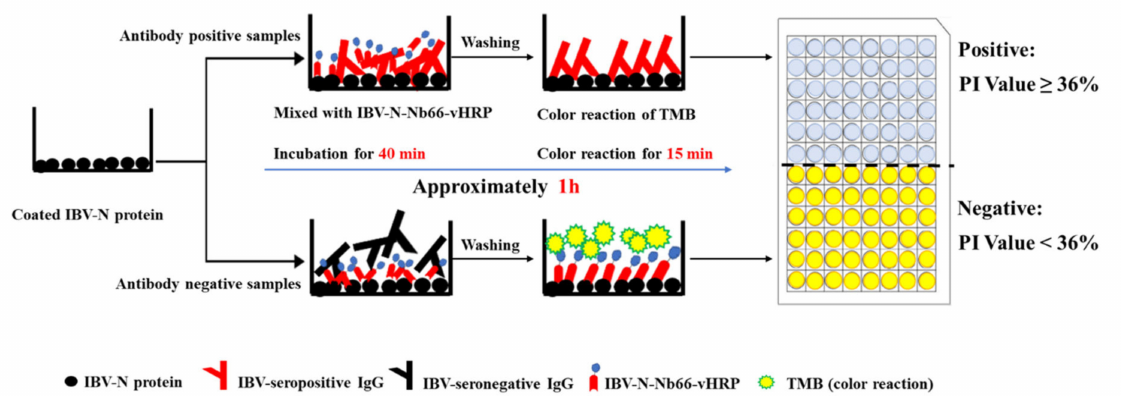
Figure 7. Schematic diagram of competitive ELISA test procedure for IBV antibody